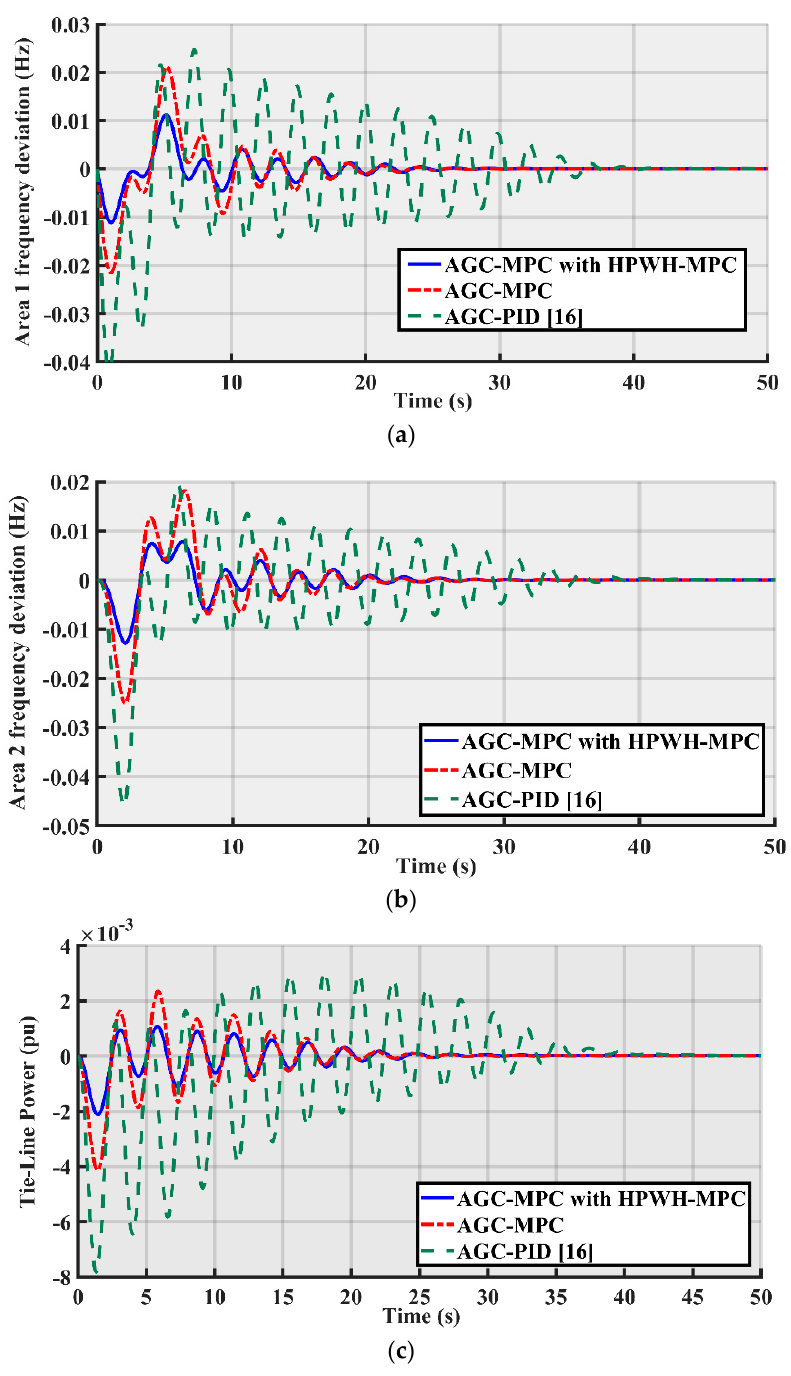
Figure 12. System performance in third scenario: ( a ) frequency deviation of Area 1, ( b ) frequency deviation of Area 2 and ( c ) tie-line power deviation.